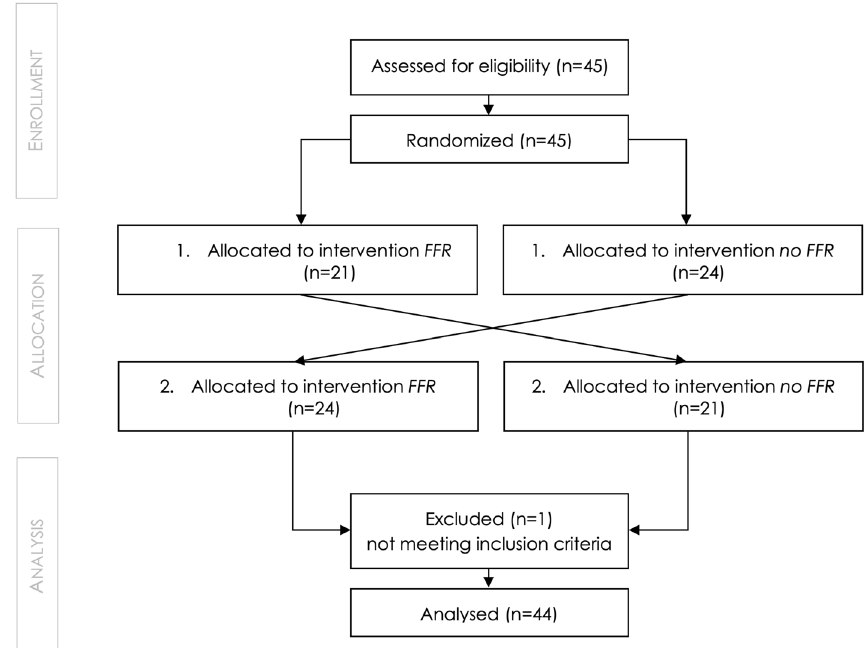
Figure 5. Flow-Chart of the participant flow through the data